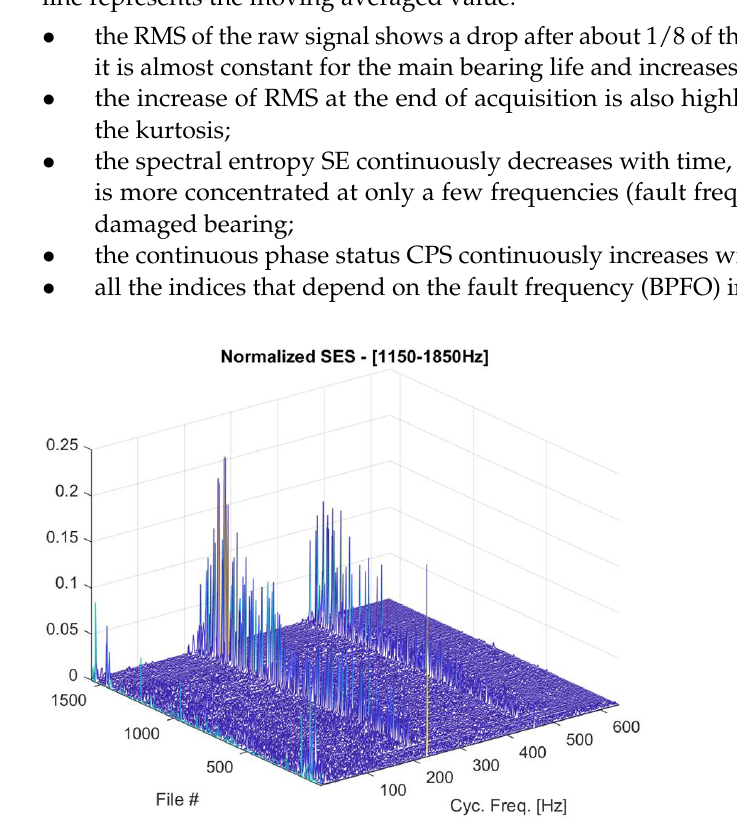
Figure 5. Values of the normalized SES for the different data sets—left TB. The axis on the left of the base plane is relative to the vibration records sorted in chronological order.